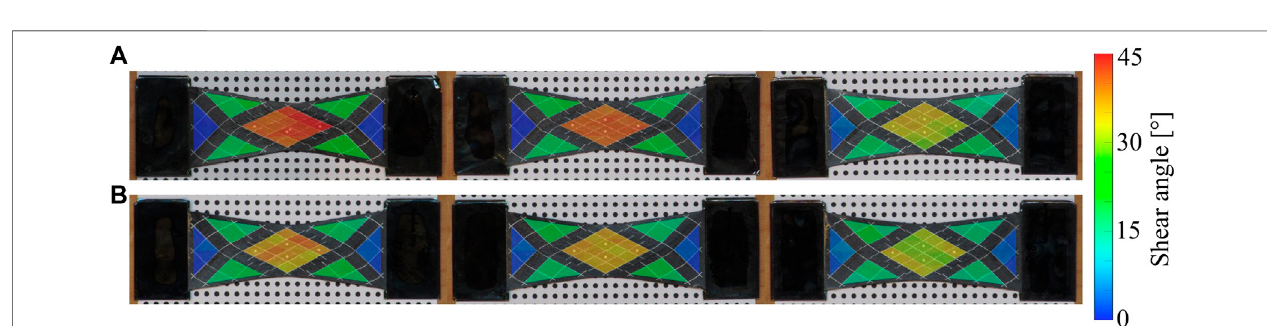
FIGURE 7 | Shear angle distribution after the test, enlarged examples. (A) Solvay APC. (B) Toray TC1225. From left to right: 345, 365, and 385 ° C. Test rate: 400 mm/min. Note: Colors are half transparent overlay on specimen pictures leading to a darker appearance.